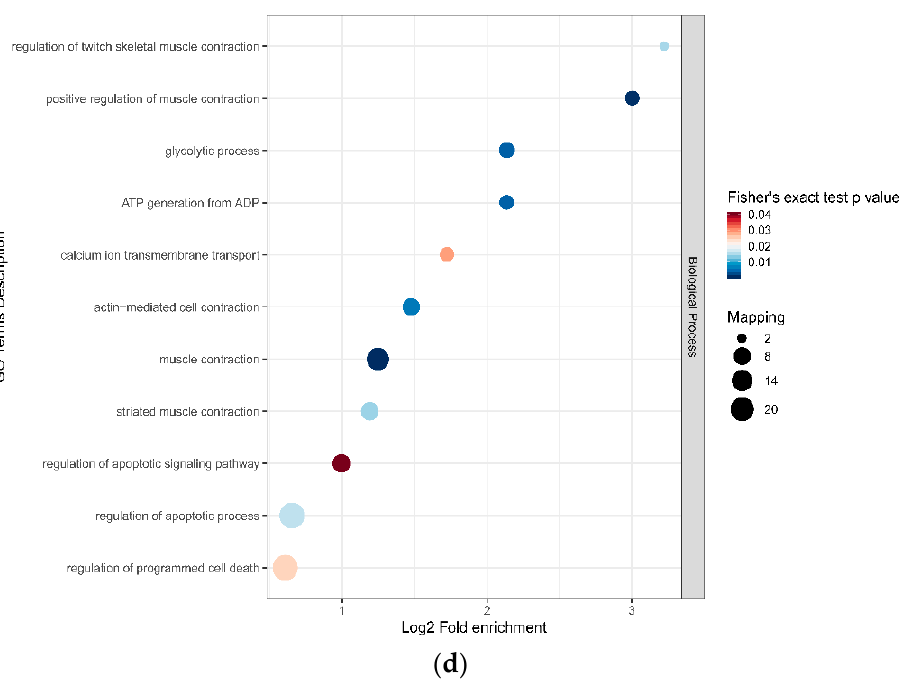
Figure 3. Functional analysis of differentially expressed proteins in postmortem pork muscle. ( a , b ) Subcellular localizations of differentially expressed proteins at 0–12 h postmortem and 12–48 h postmortem, respectively. ( c , d ) GO functional enrichment bubble plot of the differentially expressed proteins at 0–12 h postmortem and 12–48 h postmortem,